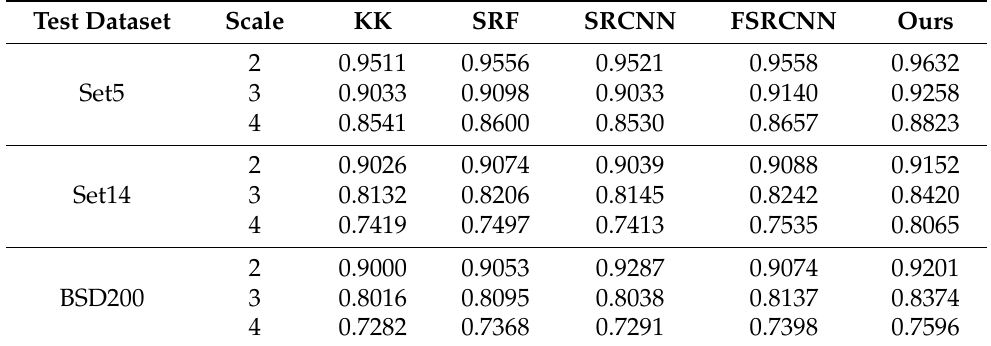
Table 1. The results of SSIM on three test datasets.